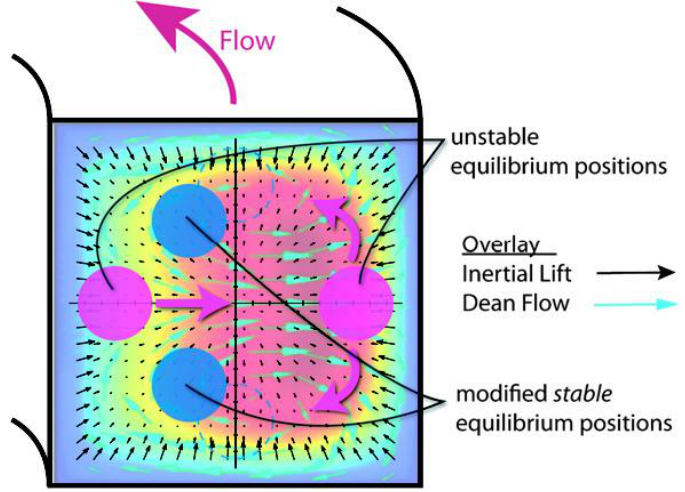
Figure 5. Superposition of effects of inertial migration and secondary flow on particles in curved channel cross-section. Ref. [40]. Copyright (2009), with permission from Royal Society of Chemistry.